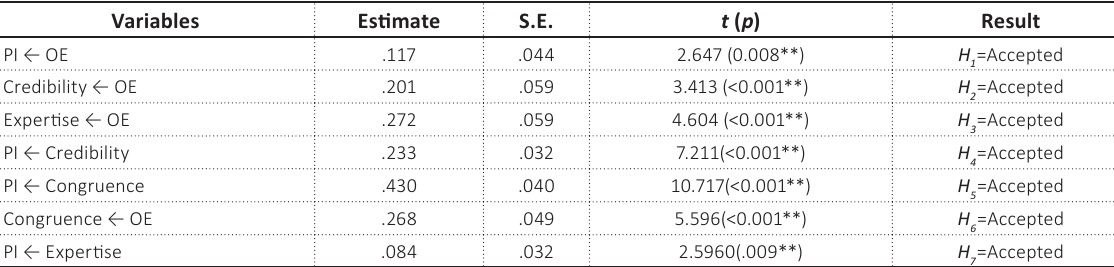
Table 5. Hypothesis